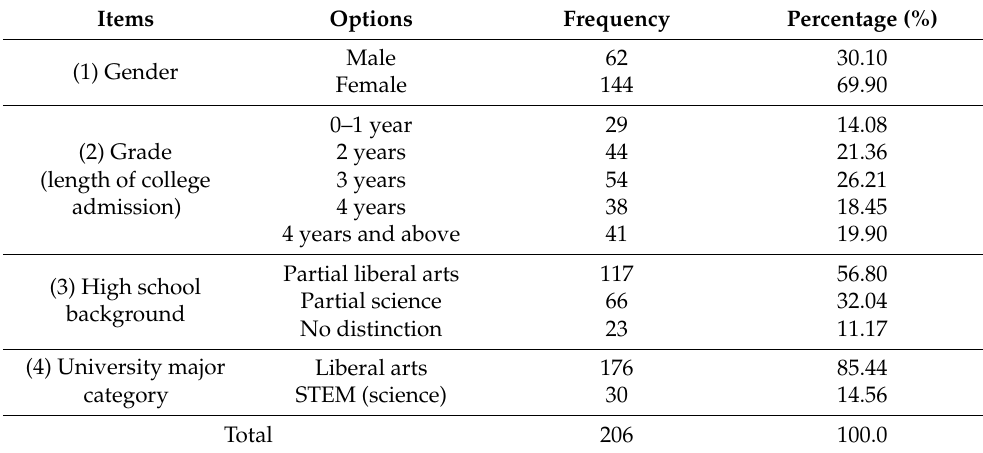
Table 1. Basic statistics of